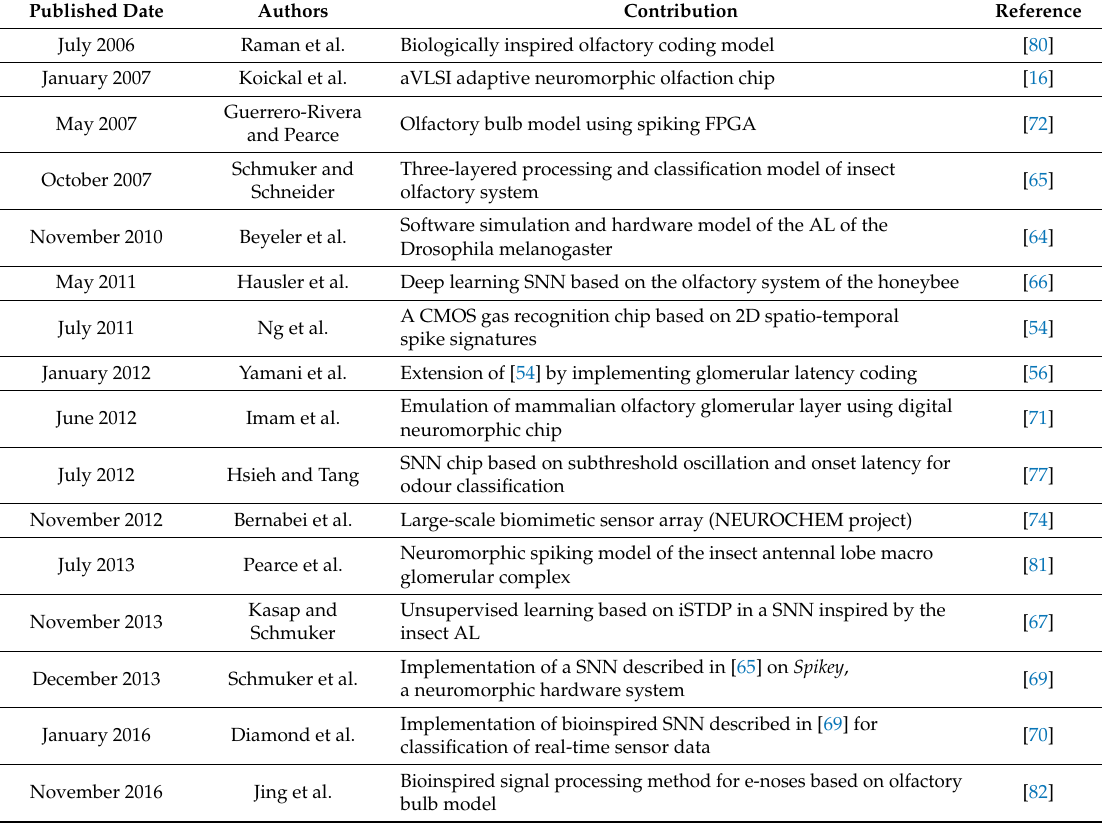
Table 1. Major contributions in neuromorphic